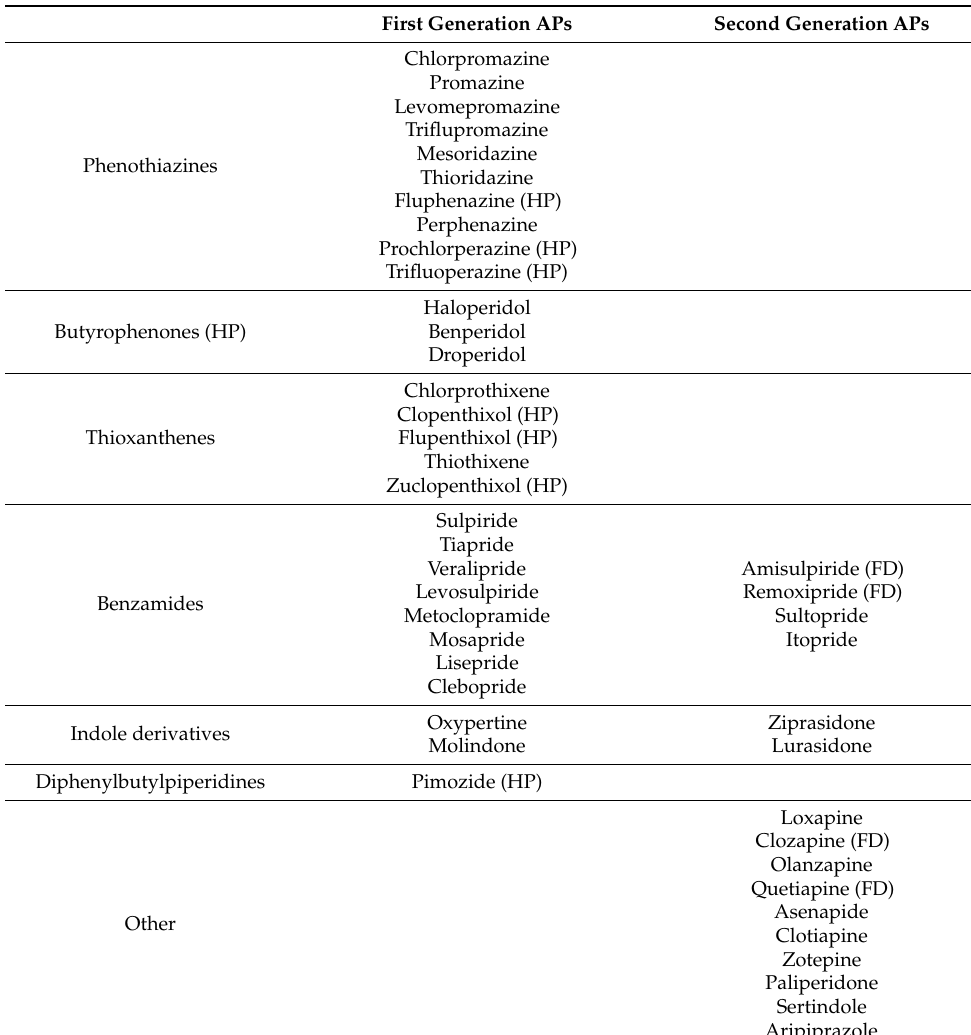
Table 2. Groups of antipsychotic and other anti-D2R drugs.